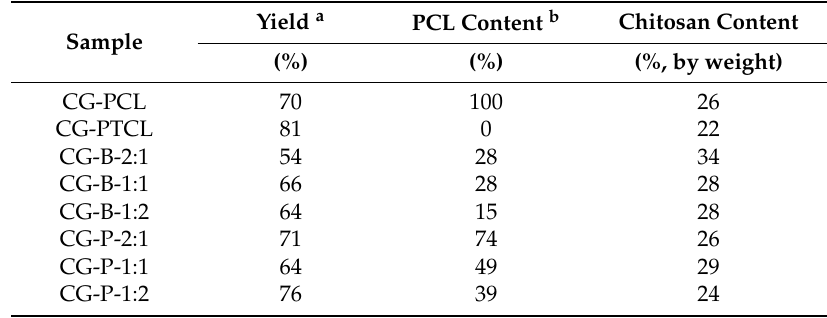
Table 3. Yield and composition of chitosan-graft-polyester